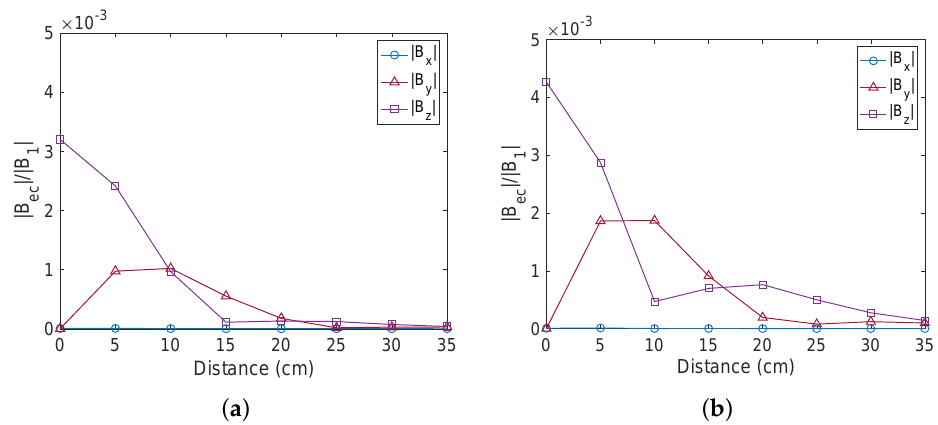
Figure 10. Simulated results of the induced fields in the x -, y - and z -direction as ( a ) the solid aluminium cylinder and ( b ) the solid steel cylinder were moved